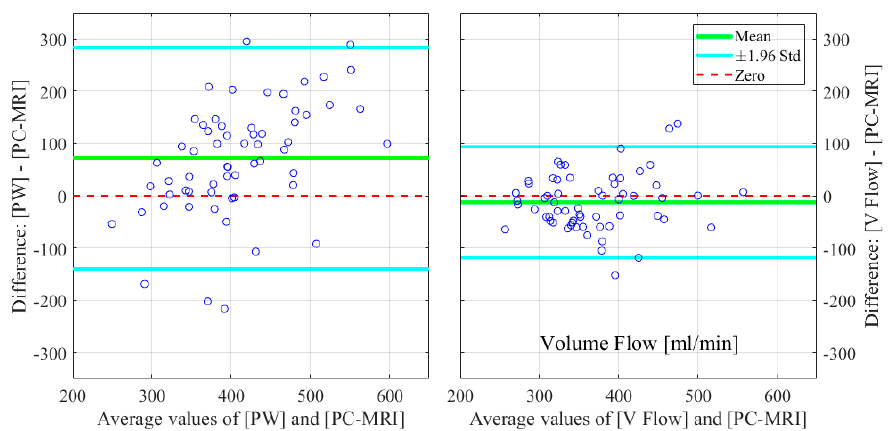
Figure 9. Linear regression plots of volume flow measurements with 95% PI and 95% CI for PW and V Flow relative to PC-MRI.